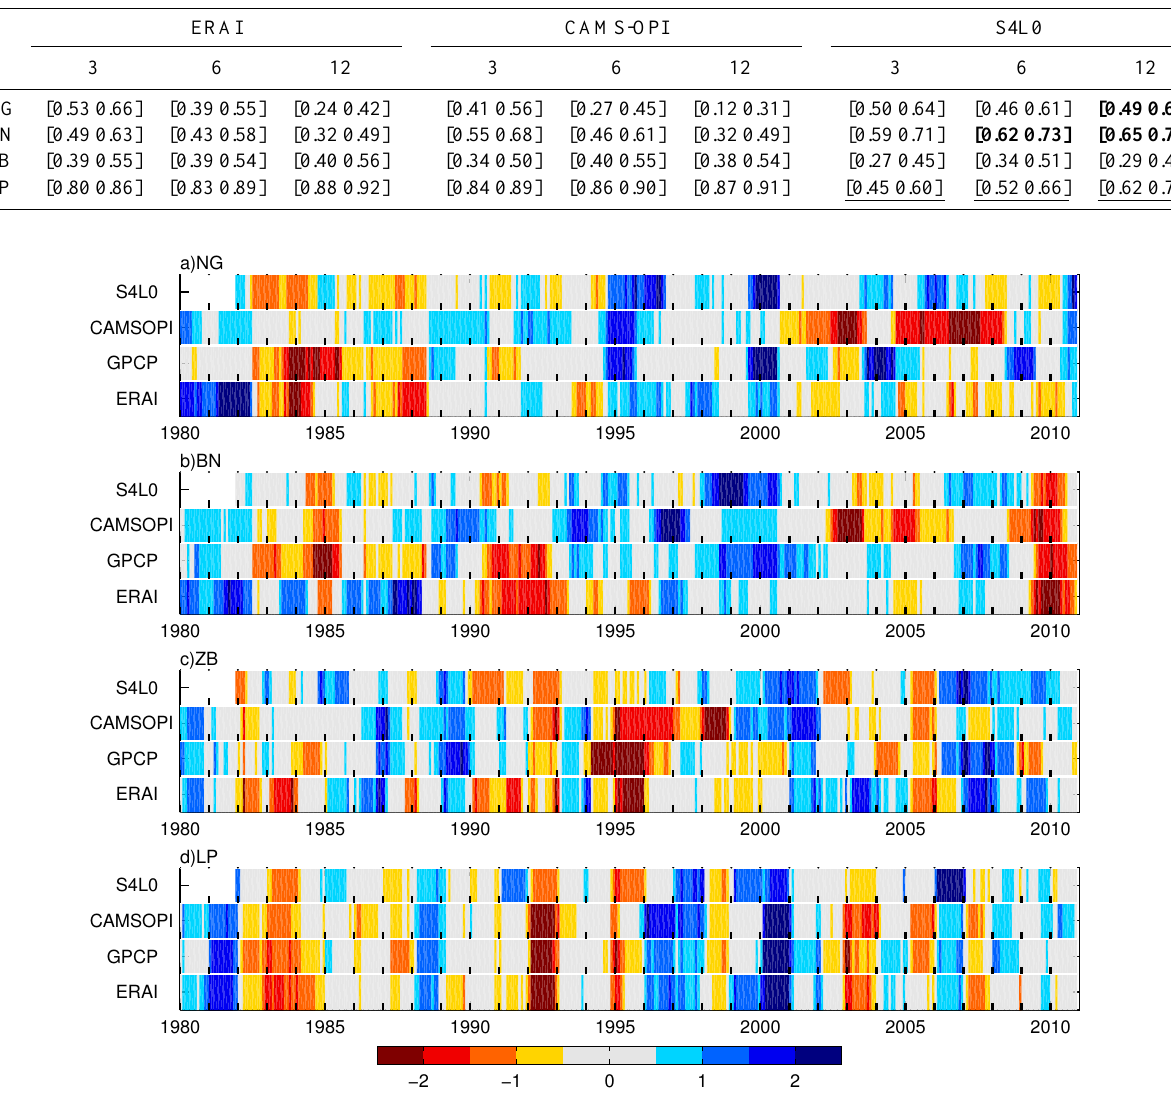
Fig. 4. Evolution of the 12-month SPI in the different basins given by S4L0 (first forecast month), CAMS-OPI, GPCP and ERAI precipitation. The horizontal ticks represent January of each